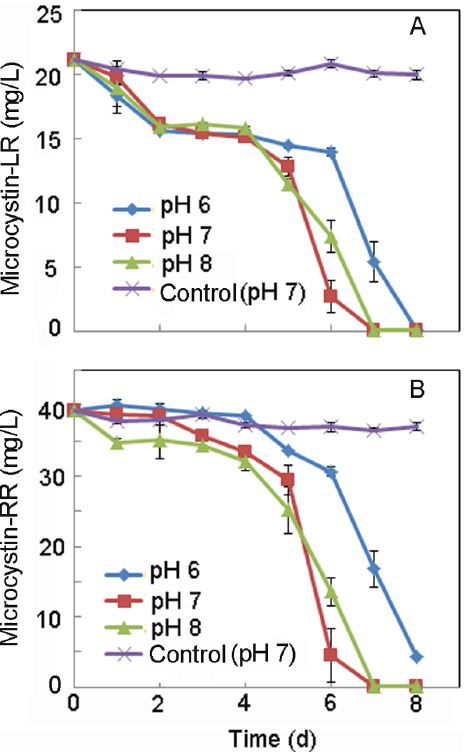
Figure 3. Effect of pH values on the degradation of MC-LR (A) and MC-RR (B) by MC-LTH2.